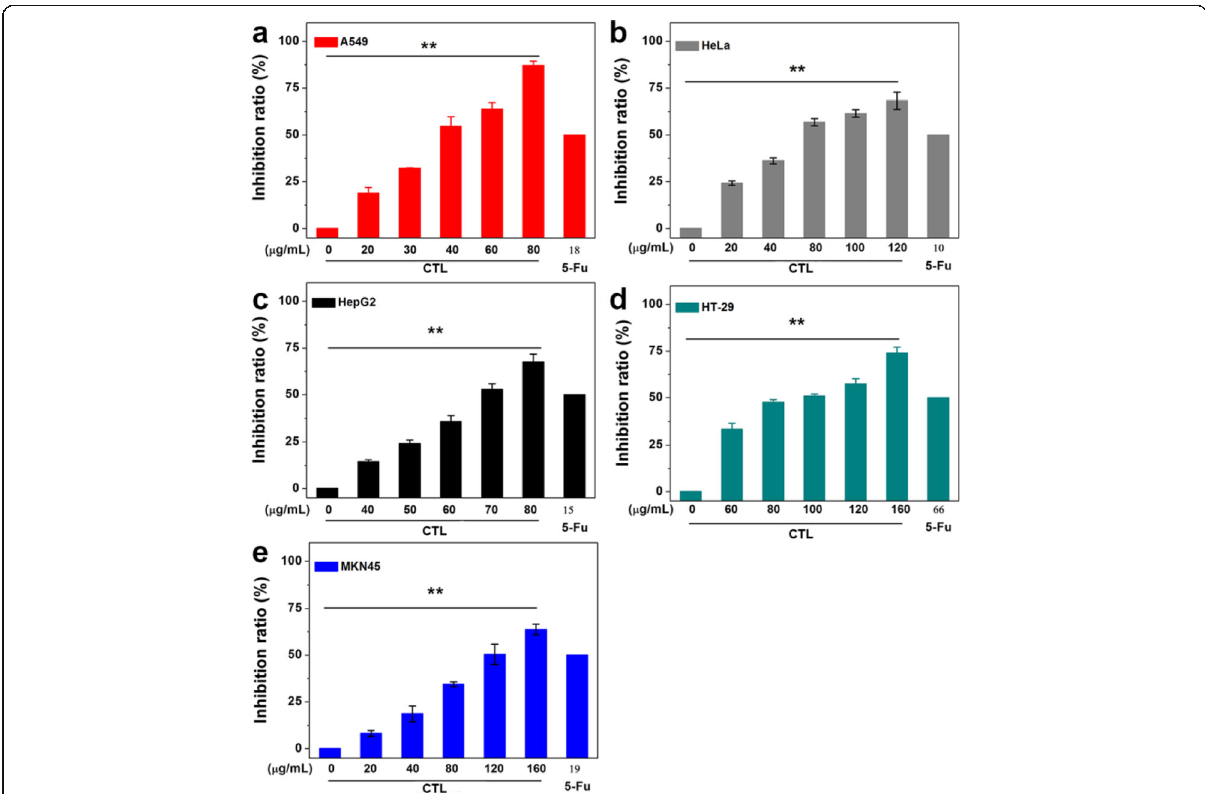
Fig. 1 Cytotoxicity of of total lignans from pine needle of CD on five human cancer cell lines. a Human lung cancer A549 cells. b Human cervical carcinoma HeLa cells. c Human hepatocellular carcinoma HepG2. d Human colon carcinoma HT-29 cells. e Human gastric cancer MKN45